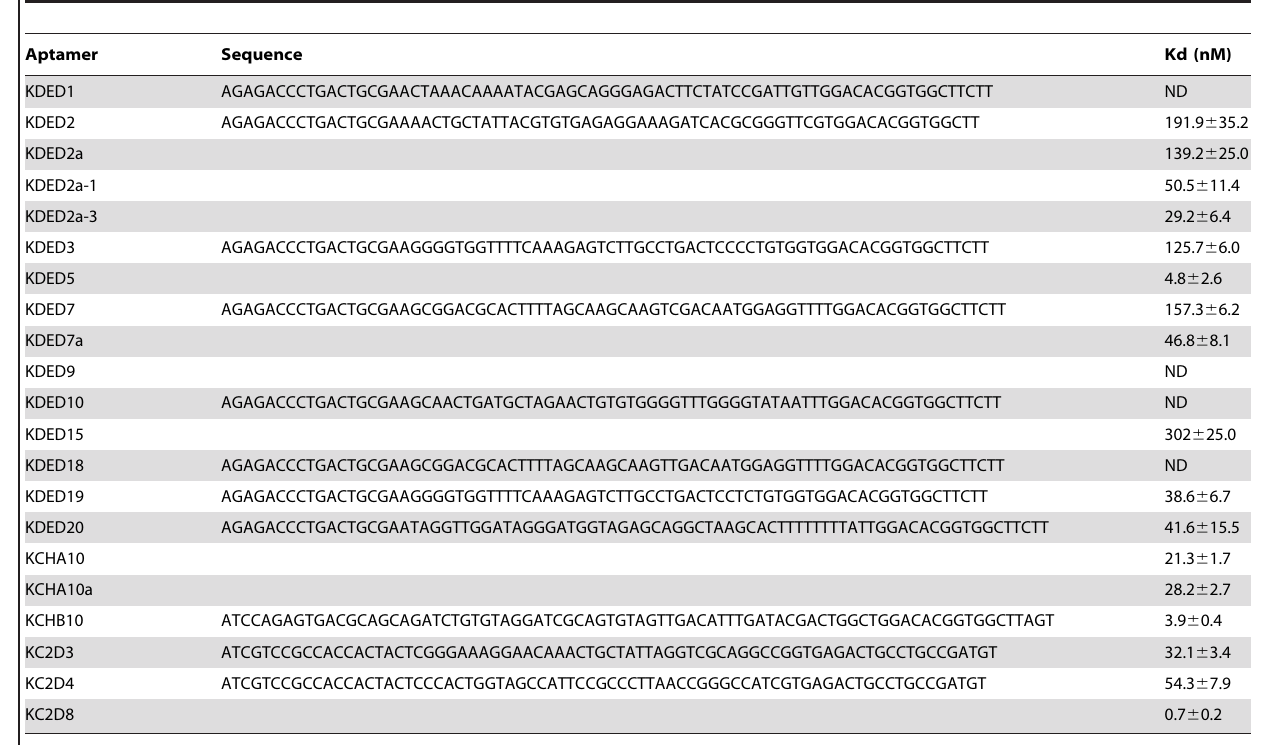
Table 2. Different aptamer sequences and their corresponding apparent dissociation constants